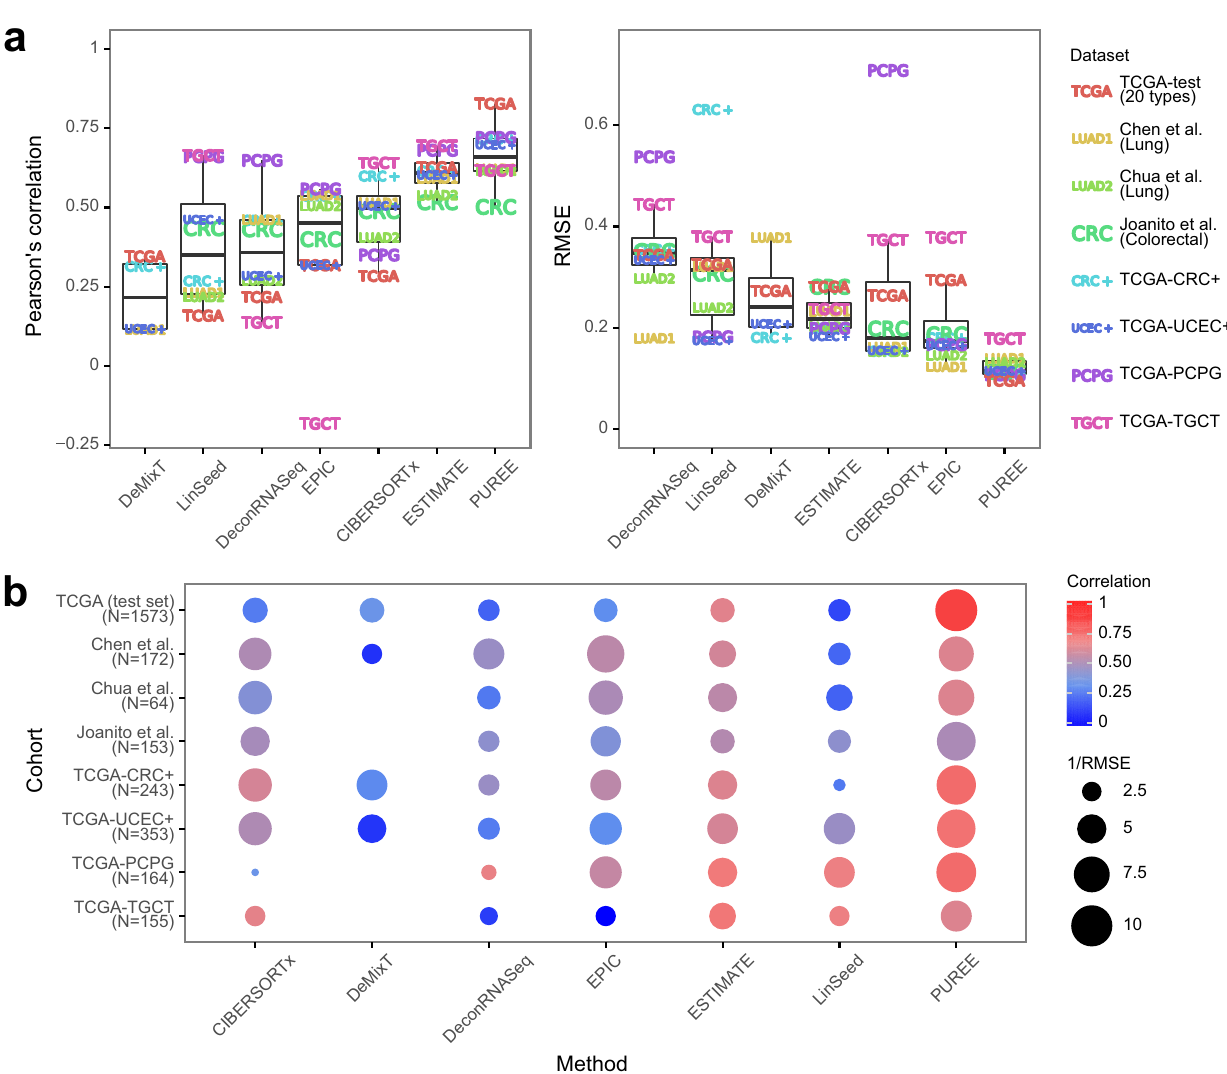
Fig. 5 Benchmarking of methods on independent datasets. Comparing the purity estimates of PUREE and 6 existing transcriptome deconvolution methods. The predictions from each method were compared with genomic tumor purity estimates across 8 cohorts: the TCGA test set, lung cancer samples from Chen et al. 36 , lung cancer samples from Chua et al. 37 , a colorectal cancer cohort from Joanito et al. 38 , and 4 TCGA cohorts of colorectal (CRC + ), uterine endometrial (UCEC + ), pheochromocytoma and paraganglioma (PCPG), and testicular cancer (TGCT) not present in the initial TCGA dataset used for training and testing. a Mean Pearson ’ s correlation and RMSE per cohort for all methods. b Mean correlation and RMSE per cohort of every method shown together. DeMixT could not be run on the Chua et al., Joanito et al., PCPG and TGCT cohorts due to the absence of normal samples there. In the boxplots in a , the lower and upper hinges correspond to the fi rst and third quartiles, the upper whisker extends to the largest value no further than 1.5 of inter-quartile range from the hinge, the lower whisker extends to the smallest value no further than 1.5 of inter-quartile range from the hinge, and points beyond the end of the whiskers are plotted TCGA training and test set construction . The TCGA dataset consisted of 7864 samples from 20 solid cancer types. 80% of samples were selected for model training (TCGA train split, 6291 samples) and 20% for testing (TCGA test split, 1573 samples). The training and test sets were randomly sampled so they had comparable cancer-type and purity distributions. The initial gene expression fea- ture matrix was fi ltered to only include autosomal and protein-coding genes. Genes with low expression (median TPM< 1) and low variance (variance < 1) in all cancer types in the TCGA train split were further fi ltered, leaving 9554 gene expression features for subsequent steps (referred to as the 10 K features set).